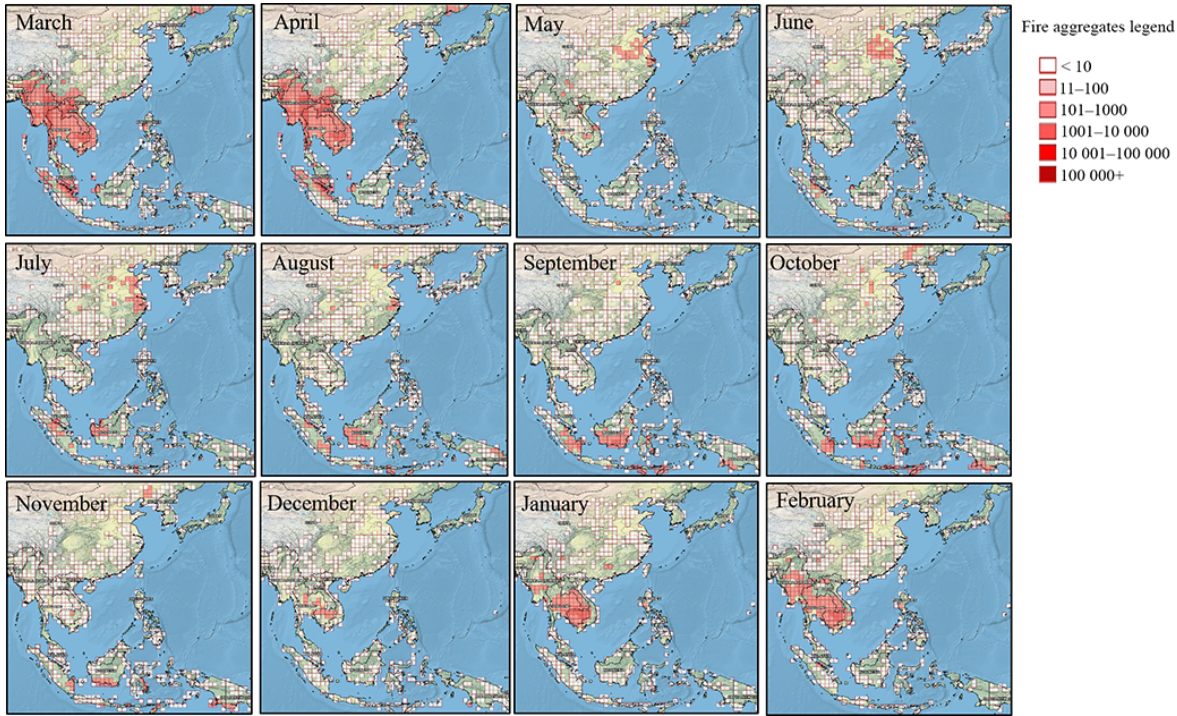
Figure 8. Fire spot data from MODIS global fire mapping from March 2014 to February 2015 around South China Sea (https://firms.modaps.